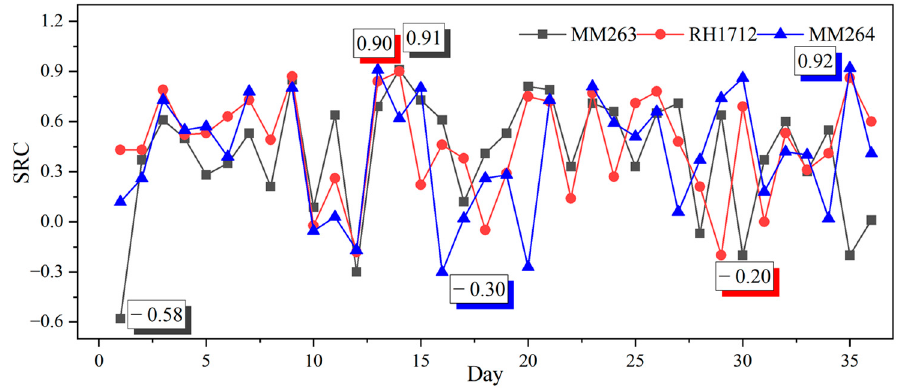
Figure 6. The change of SRC with time.